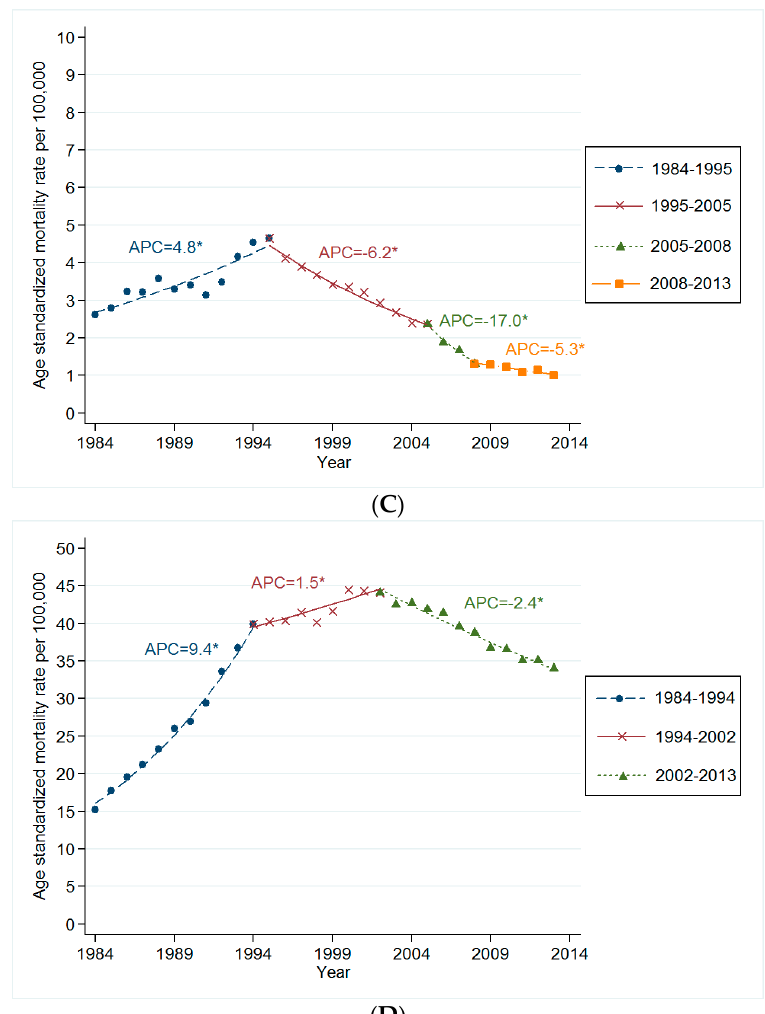
Figure 1. ( A ) Trends in age-standardized mortality rate for oropharyngeal cancer in Korean men. Footnotes: The age-standardized mortality rates are presented as number of oropharyngeal cancer per 1,000,000 people using Segi’s world standard population as standard population. Joinpoint regression analysis was used to determine whether there were significant changes in trends in age-standardized mortality rates for the period between 1984 and 2013; ( B ) Trends in age-standardized mortality rate for esophageal cancer in Korean men. Footnotes: The age-standardized mortality rates are presented as number of esophageal cancer per 1,000,000 people using Segi’s world standard population as standard